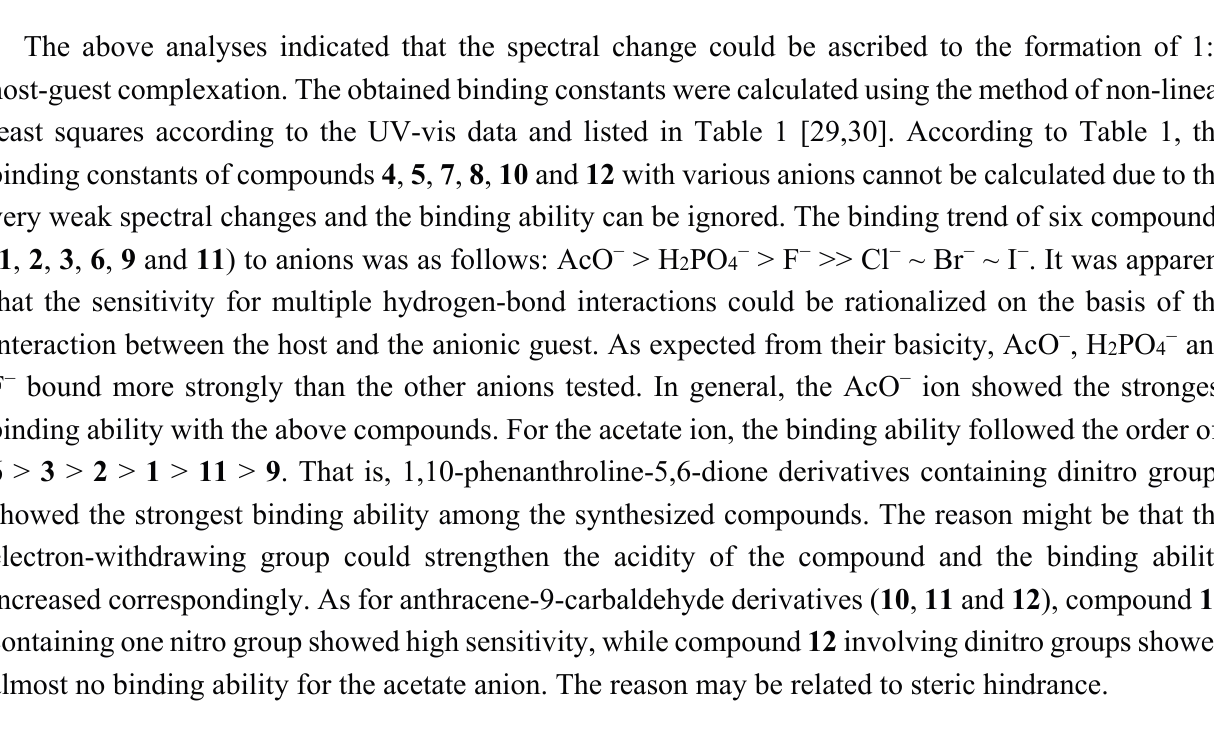
Table 1. Binding constants of compounds with various